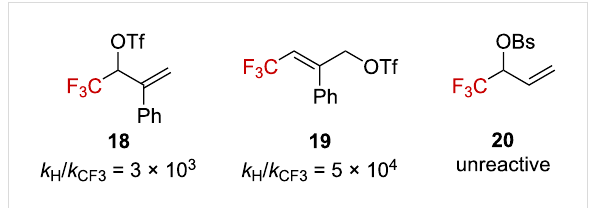
Figure 3: Structures of allyl triflates 18 and 19 and allyl brosylate 20 . Bs = p -BrC 6 H 4 SO 2